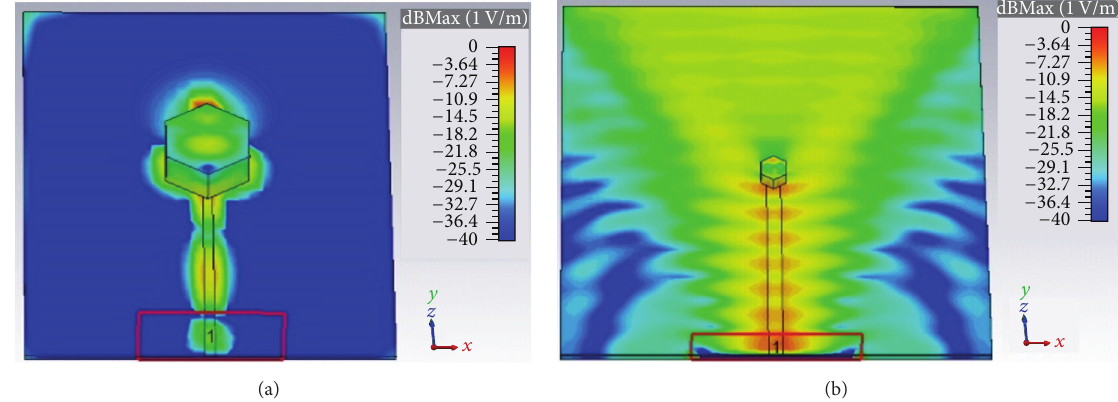
Figure 5: (a) 𝐸 -field propagation having fringing effects in the transmission line of a hexagon dielectric resonator at microwave frequencies [25]. (b) 𝐸 -field propagation having travelling wave effects in the nanostrip transmission line of the proposed nantenna.